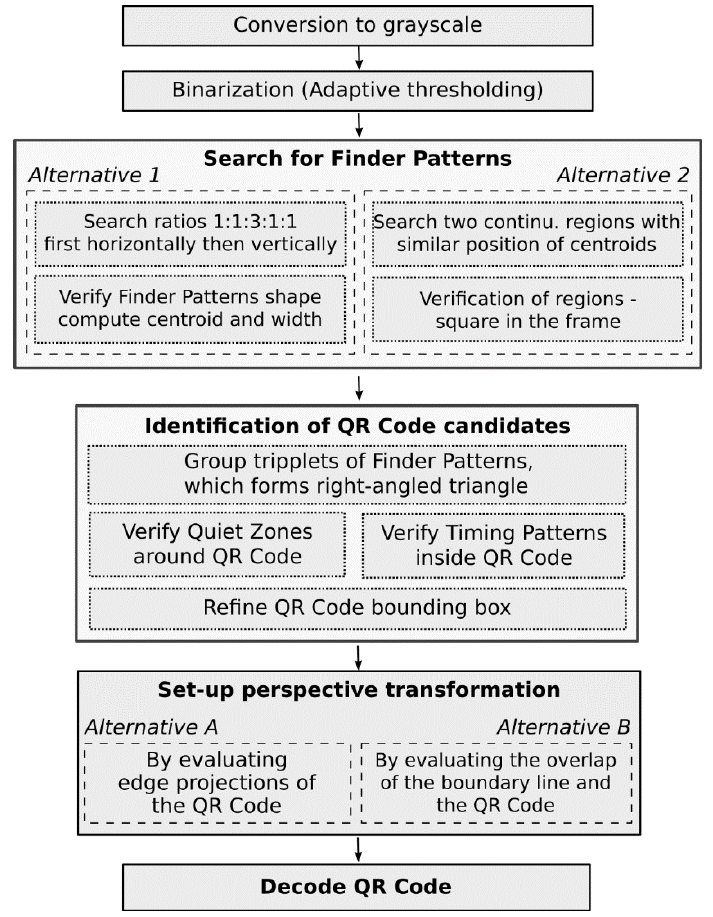
Figure 2. The flow chart of the proposed algorithm.